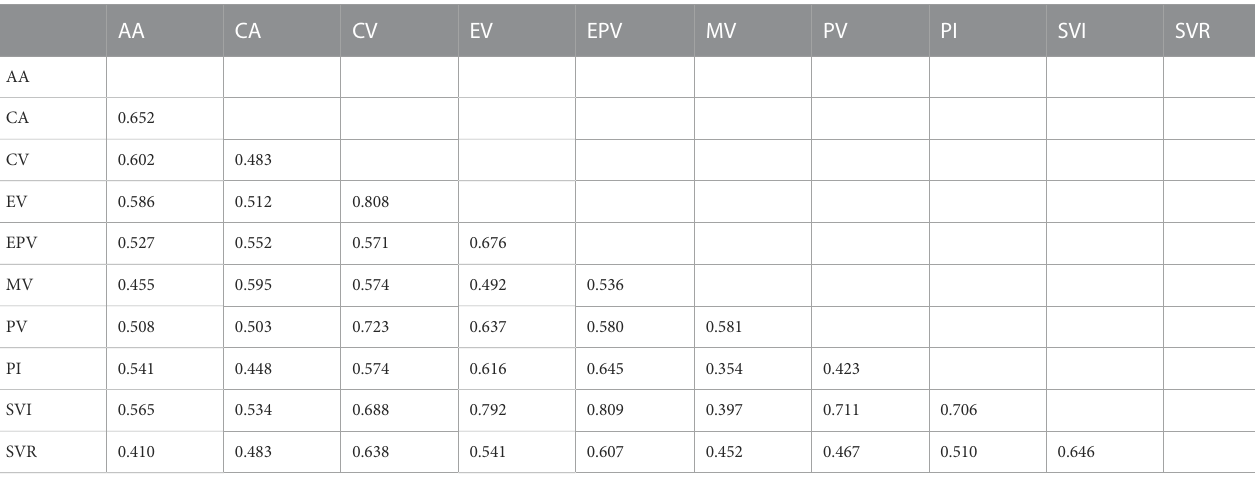
TABLE 4 Discriminant Validity HTMT